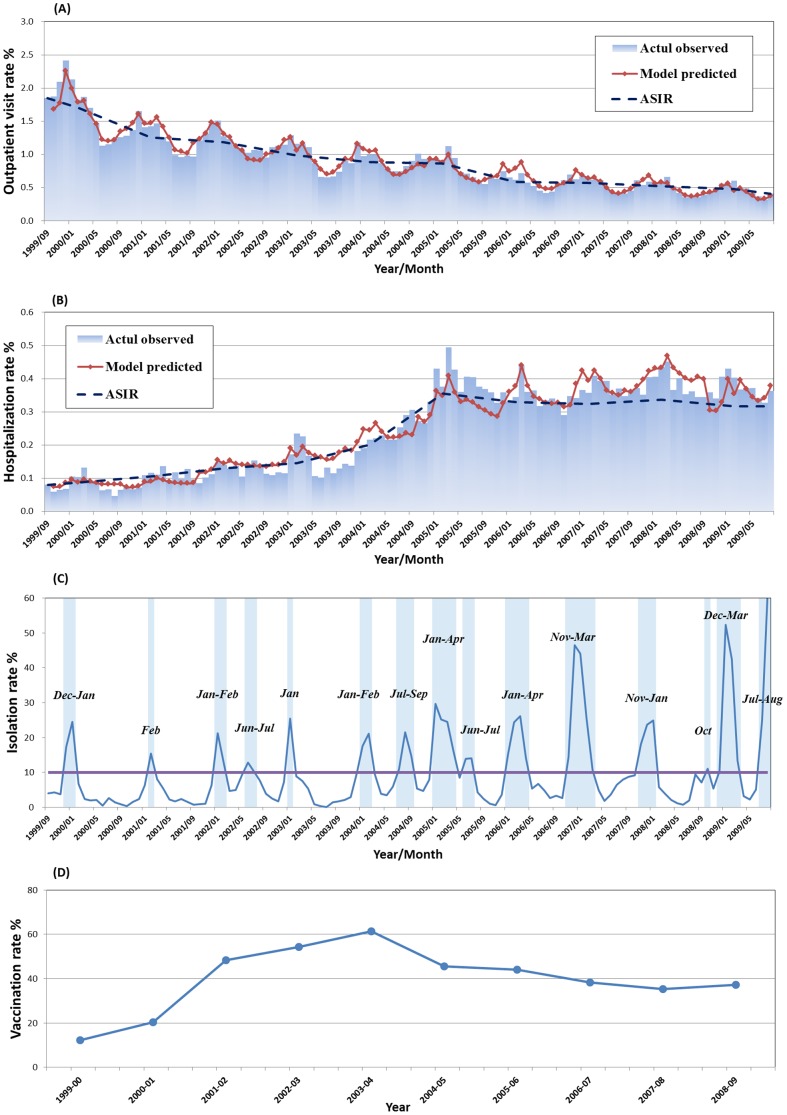
Study event rates among the elderly ≥65 years old over the study period from 1999–2000 to 2008–2009 influenza seasons in Taiwan.Panel A and Panel B represents pneumonia and influenza (P&I)-related outpatient visit and hospitalization rates. The actual observed events (Blue-shaded area), model-predicted events (Red line) and age-standardized events (black dashed line) are expressed as monthly rates per 100. Panel C represents viral surveillance data expressed as the weekly percentage of tests positive for influenza viruses. Horizontal line sets the cutoff of isolation rate ≥10% and the influenza epidemic months are shaded in blue. Panel D represents the annual trivalent influenza vaccine (TIV) vaccination rate among the elderly in percentage. No free TIV vaccination was provided for the 5–19 age group during 1999,9–2007,8.